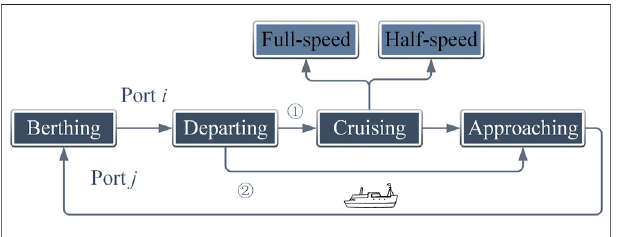
FIGURE 2 | Ship travelling modes between ports.